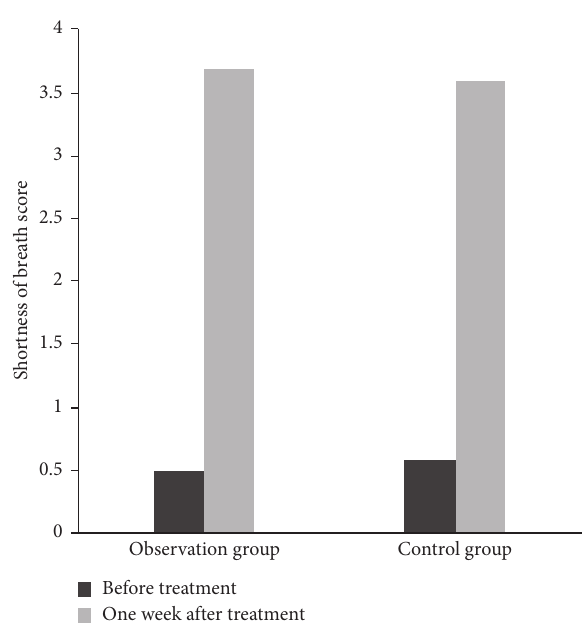
Figure 3: Comparison of the changes of airway diameter between the two groups. Note: compared with the same group before treatment ( a P < 0 . 05) and the control group after treatment ( b P < 0 .